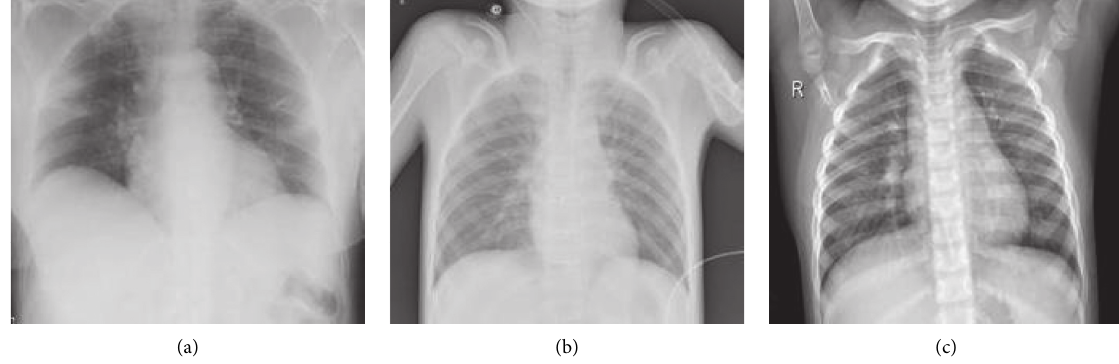
Figure 2: Chest X-ray images of the different conditions: (a) COVID-19; (b) pneumonia; (c)